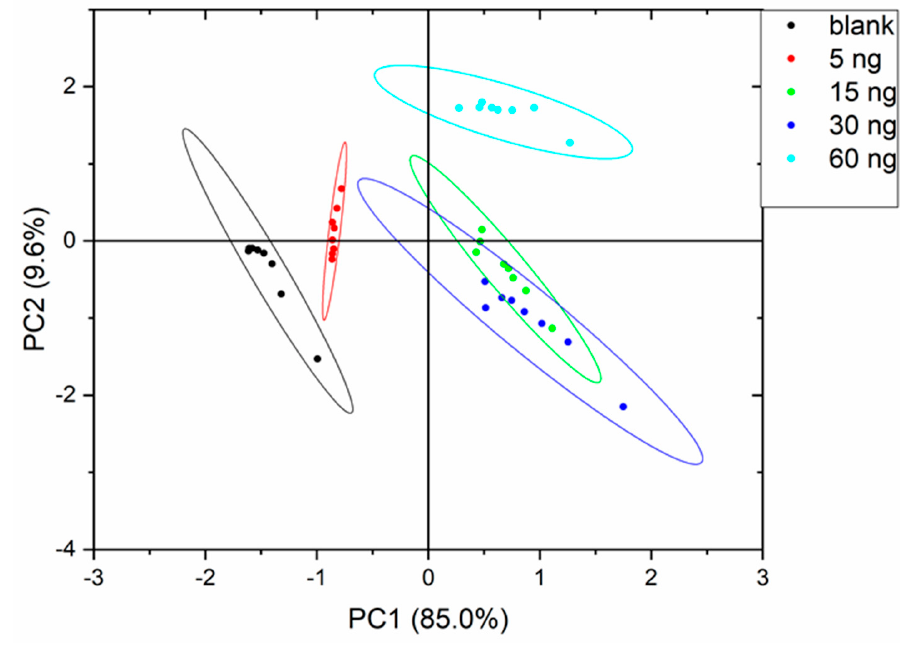
Figure 4. PCA score plot for TCA.